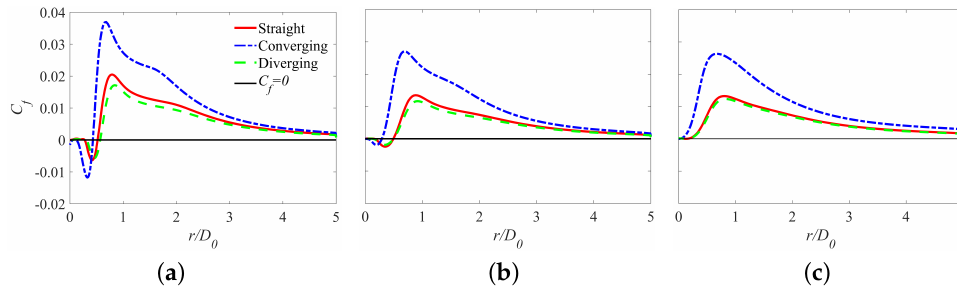
Figure 17. Axial velocity along the axis at ( a ) H = 0.5, ( b ) H = 2, and ( c ) H = 4.